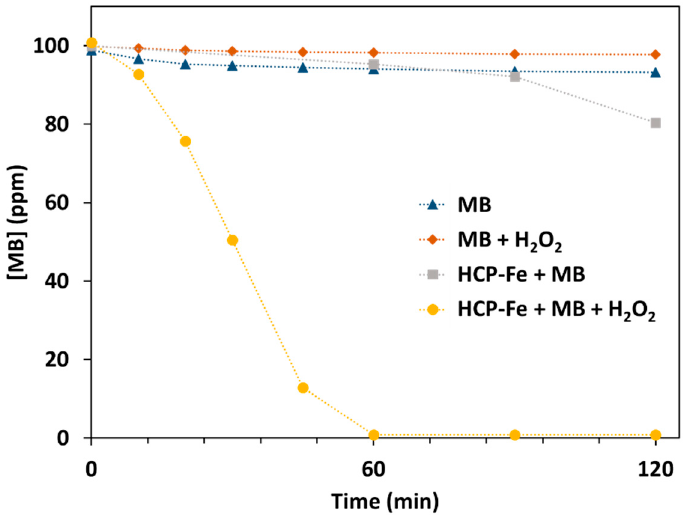
Figure 4. Concentrations of MB at different times under different conditions. Reaction conditions: [HCP-Fe] = 1 g/L, [H 2 O 2 ] = 0.5 M, [MB] = 100 ppm, pH = 6 (neutral pH), room temperature (27 °C).